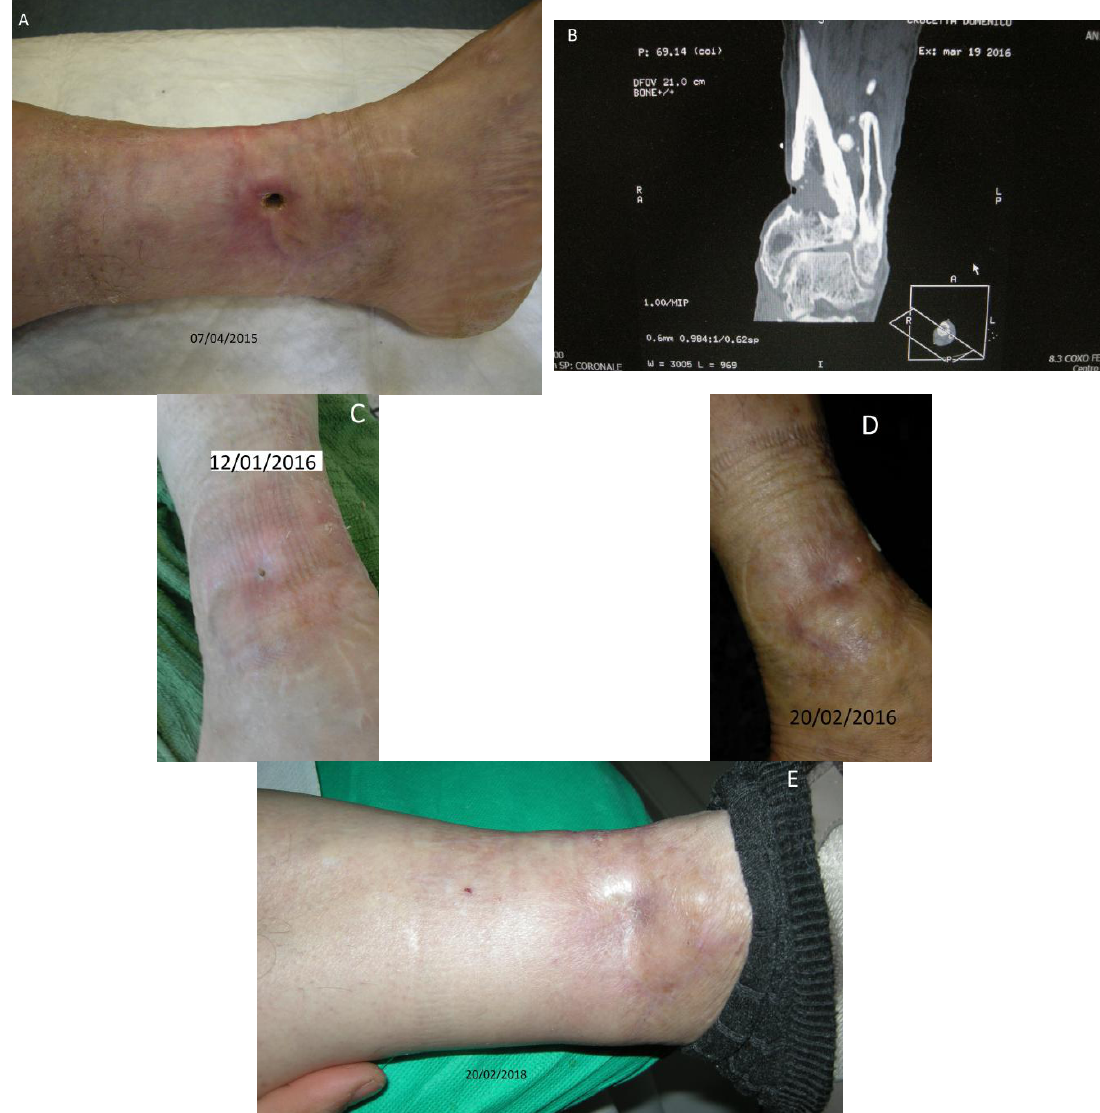
Figure 1. Case No. 1. ( A , C , D , E ) Different moments of the wound healing, stable after two years; ( B ) NMR of the patient with the bone lesion.